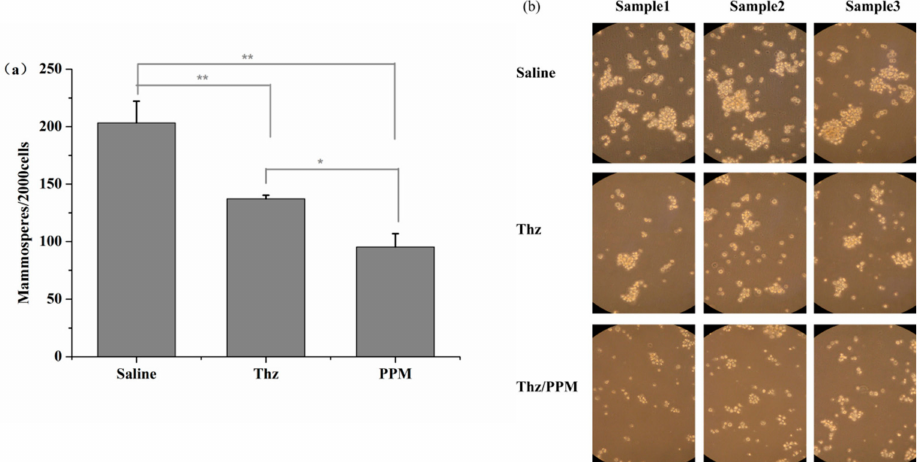
Figure 6. In vitro anti-CSCs activity. ( a ) Mammospheres number and ( b ) images of optical micrograph (magnify 200 times). * p < 0.05, ** p <